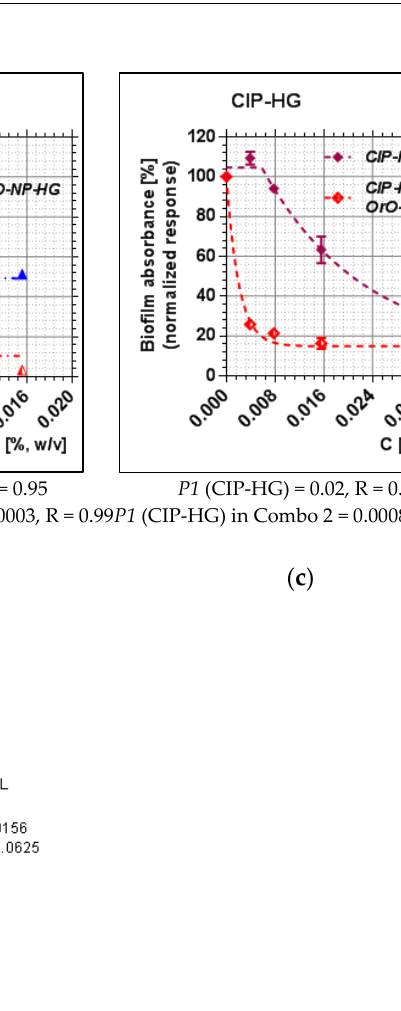
Figure 6. Inhibition of the biofilm formation by OrO-NP, gentamicin and ciprofloxacin or the syn- ergistic combinations in hydrogels — absorbance of crystal violet: ( a ) OrO-NP-HG, single application and in combinations with CN-HG or CIP-HG; ( b ) CN-HG, single application and in combination with OrO-NP-HG; ( c ) CIP-HG, single application and in combination with OrO-NP-HG. The combinations in each point are given in Table 5. ( d ) The different values of P1 denote the diminishment of the median inhibitory concentration of the hydrogel components as single application and in the tested combinations. Legend: P1 , inhibitory constant, which may be interpreted as the dose achieving 50% inhibition; R — correlation coefficient; CN — gentamicin; CIP — ciprofloxacin; OrO- NP-HG — nanoparticles with oregano oil included in hydrogels.